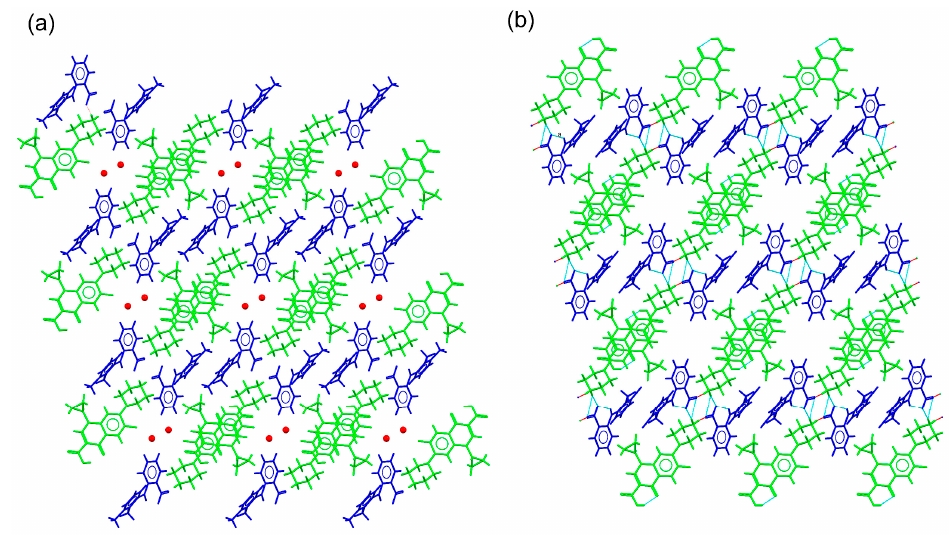
Figure 5. Detailed view of the packing arrangements for ( a ) CIP–MEF · H 2 O and ( b ) CIP–TLF. Green, CIP cations; blue, MEF and TLF anions; red, water molecules.